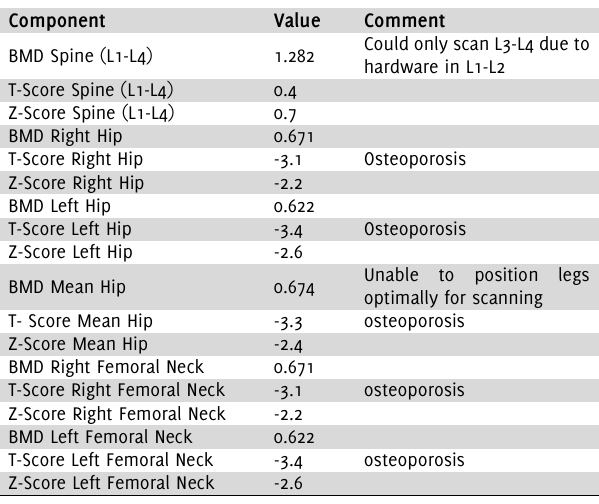
Table 1 . Bone density imaging referenced severe osteoporosis in the total hip and femoral neck bilaterally.